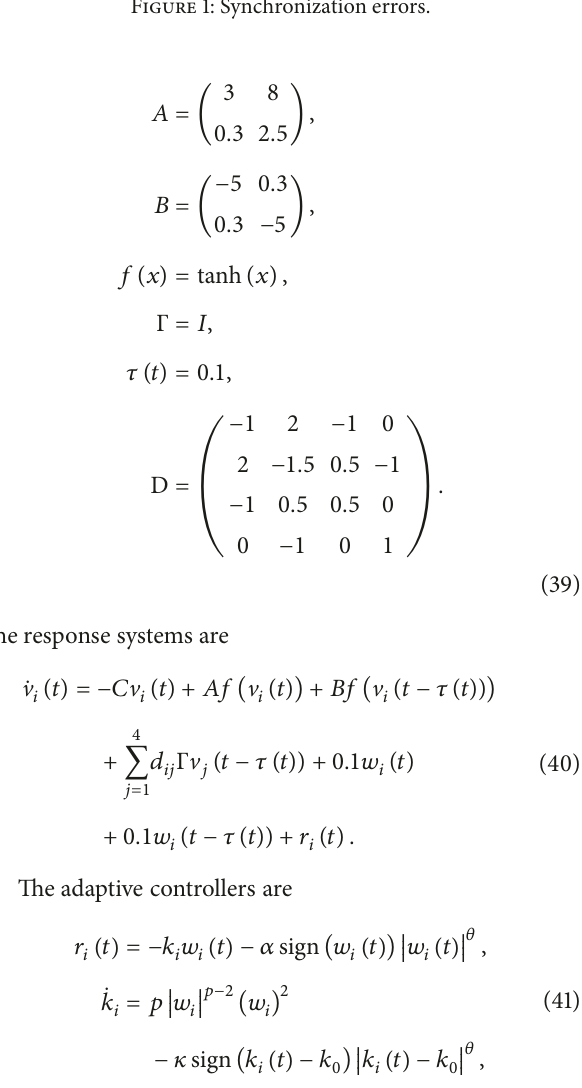
Figure 1: Synchronization errors. Figure 2: Dynamic curve of the feedback gain.